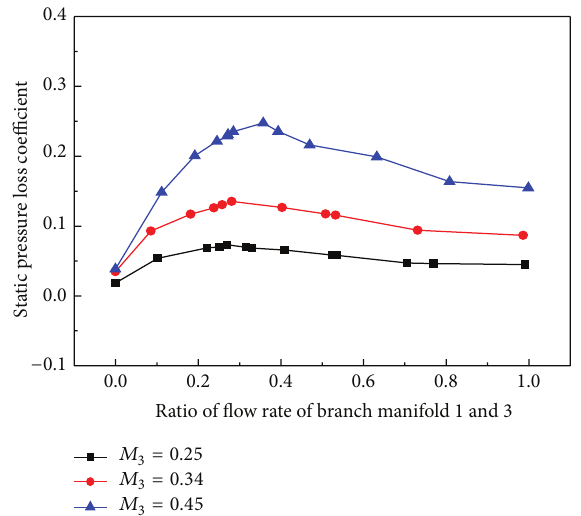
branch manifold 2 to branch manifold 3 is shown in Figure